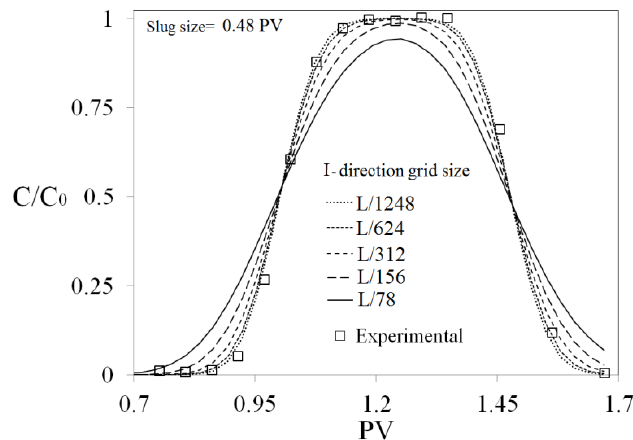
Figure 3. Relative concentration of tracer (Cl − ) in the effluent of sand-pack A. Simulation results with different I -direction grid sizes are compared with the experimental data (squares). PV: pore